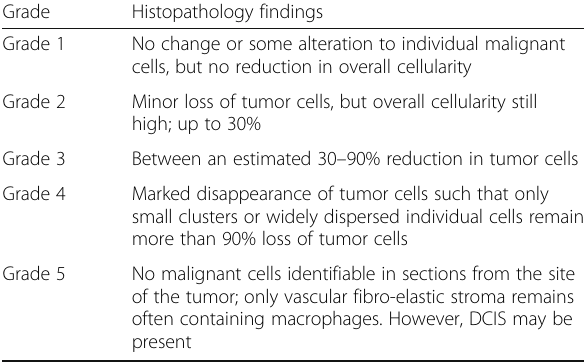
Table 2 Miller-Payne grading system